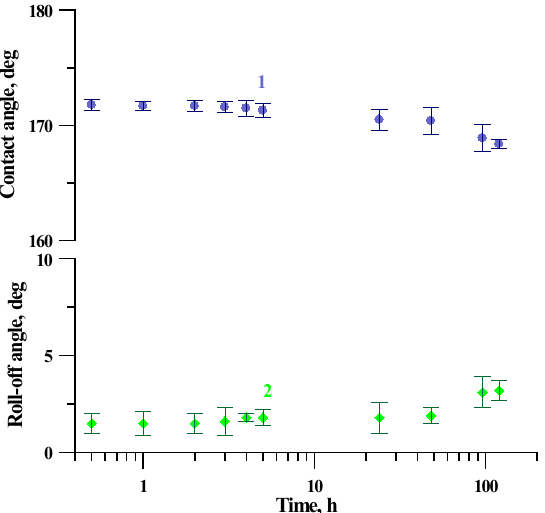
Figure 8. The variation of contact (1) and roll-off (2) angles with the time of exposure to saturated water vapors for the superhydrophobic coating on tungsten surface obtained by regime 13.